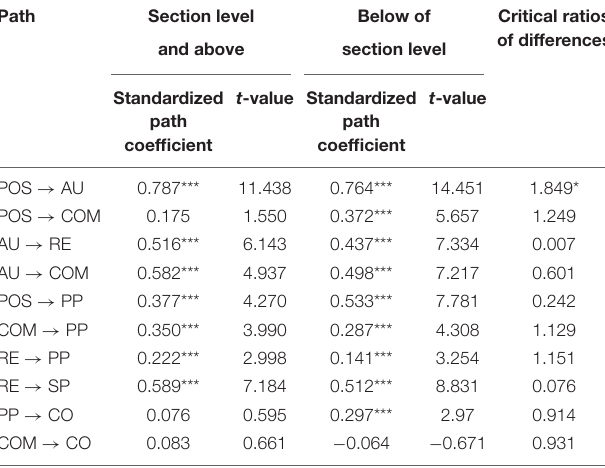
TABLE 5 | Results of multi-group analysis for position